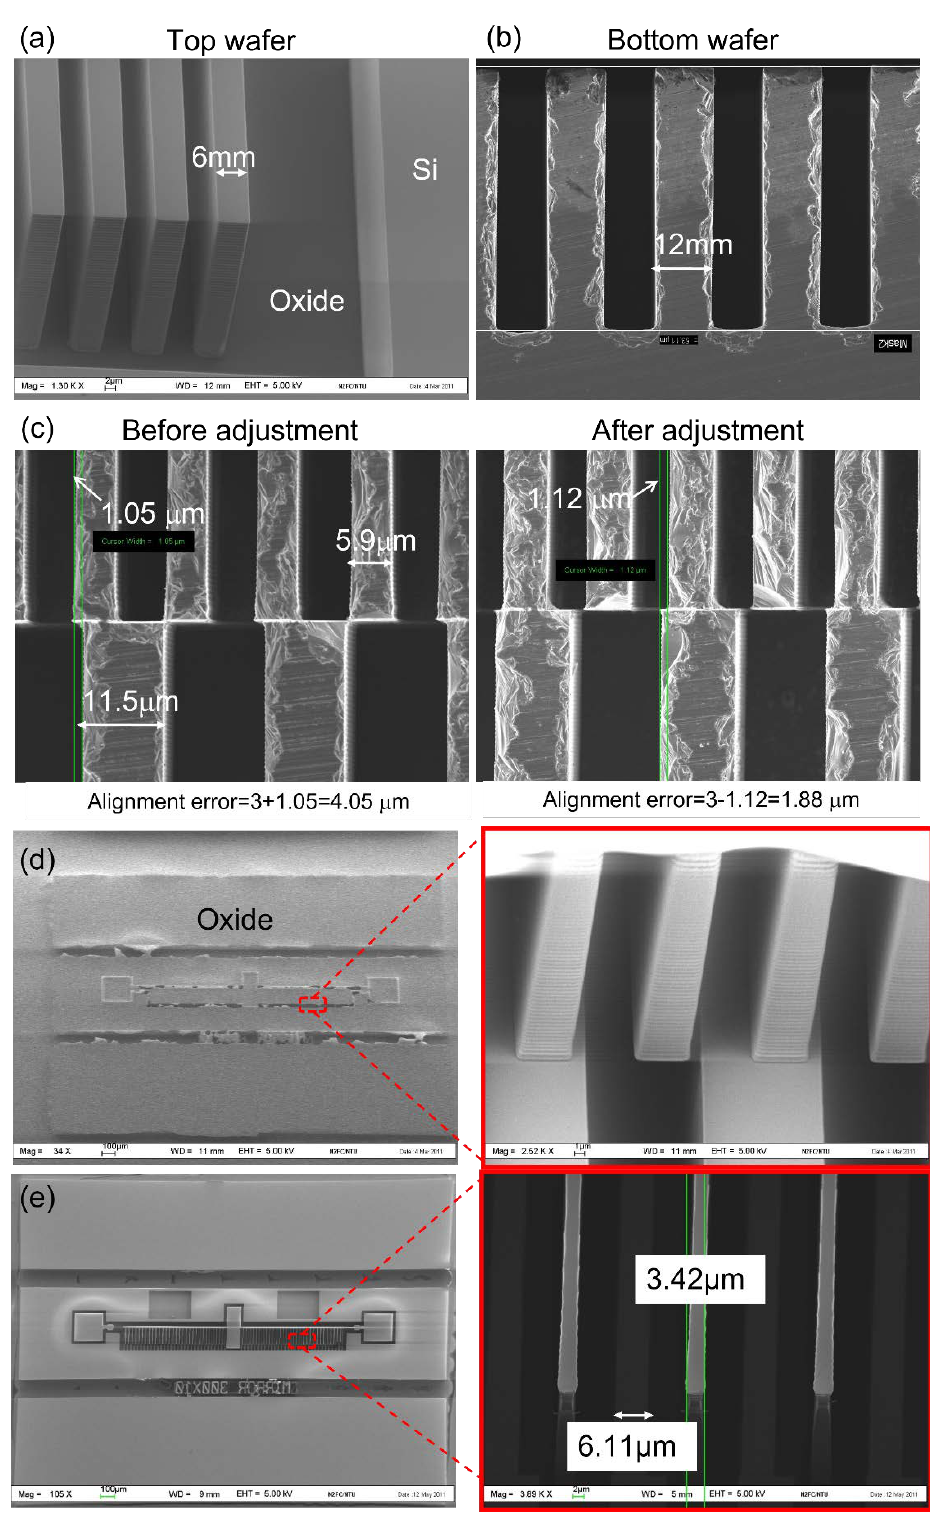
Figure 5. SEM images for ( a ) SOI wafers, ( b ) DSP wafers, ( c ) misalignment estimation after wafer bonding, ( d ) after back-side thinning and ( e ) final fabricated device.